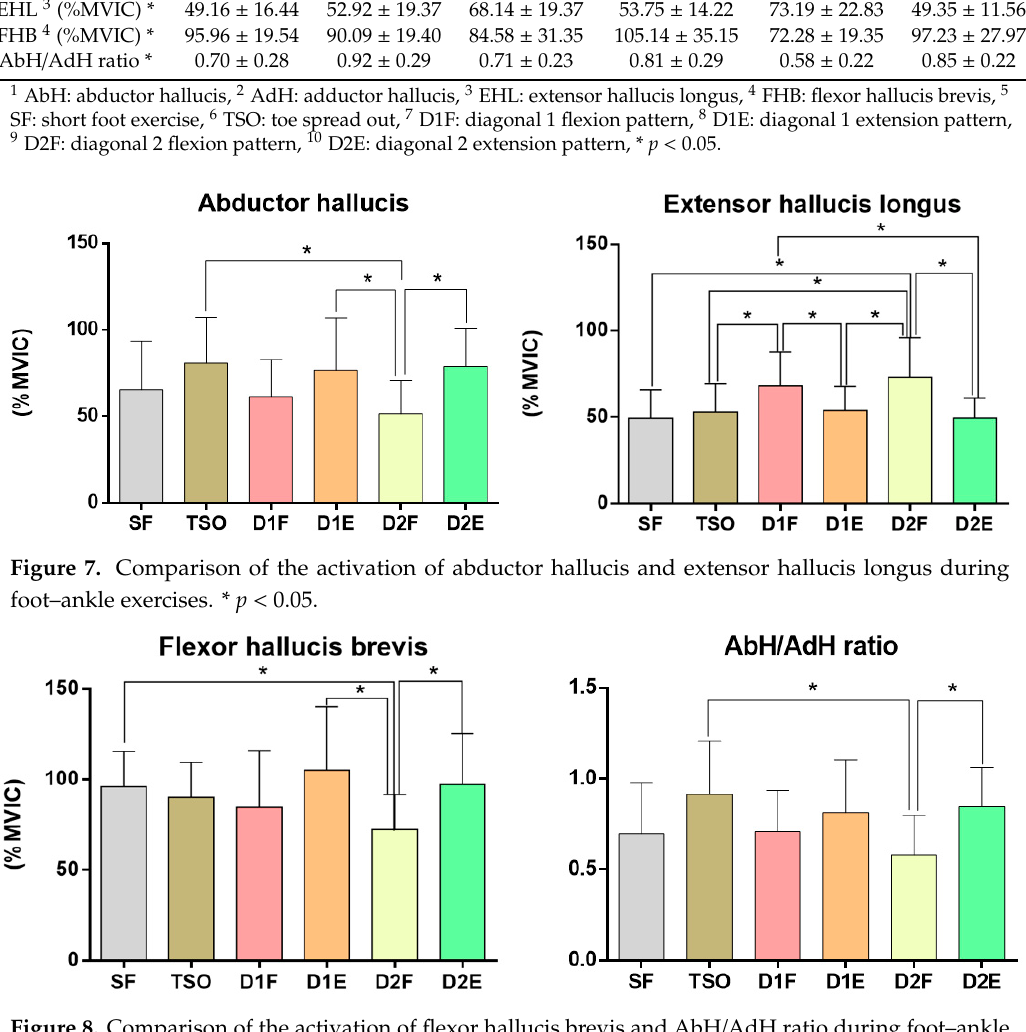
Figure 8. Comparison of the activation of flexor hallucis brevis and AbH/AdH ratio during foot–ankle exercises. * p < 0.05.